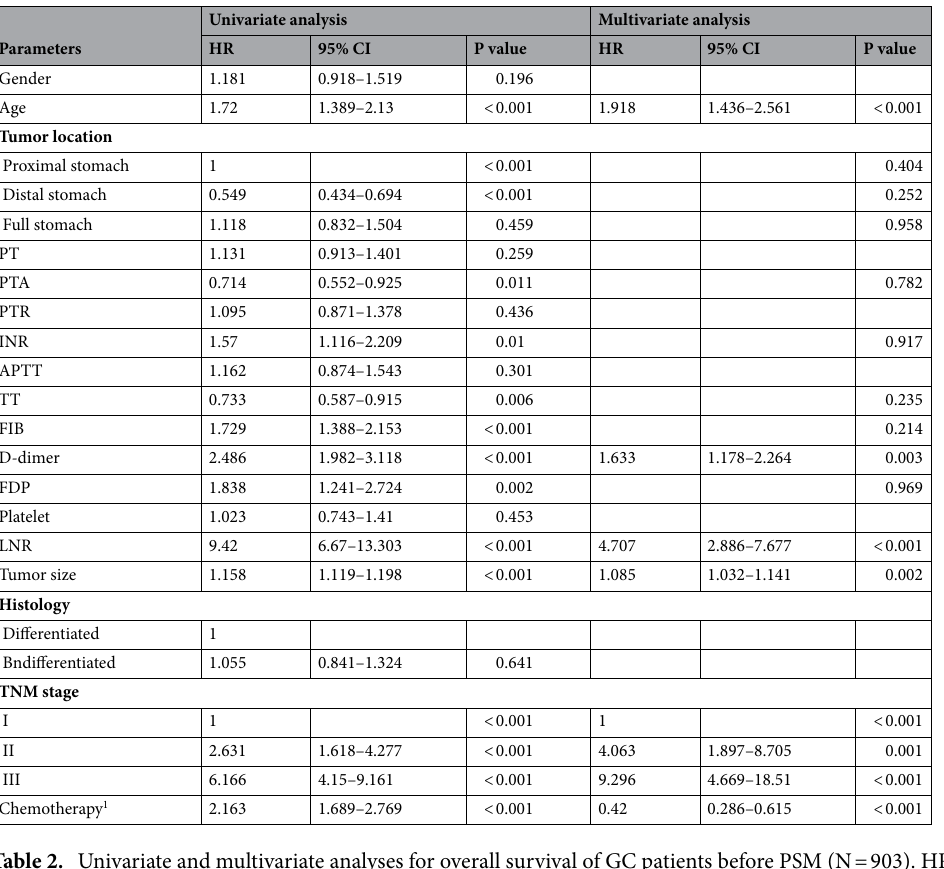
Table 2. Univariate and multivariate analyses for overall survival of GC patients before PSM (N = 903). HR, hazard ratio; CI, confidence interval; PT, prothrombin time; PTA, prothrombin activity; PTR, prothrombin ratio; APTT, activated partial prothrombin time; INR, international normalized ratio; TT, thrombin time; FIB, fibrinogen; FDP, fibrin degradation products; TNM, Tumor-node-metastasis; LNR, Lymph node ratio. Coagulation parameters were divided into two groups according to the cutoff values in Supplementary Table 2. The references of parameters were female, age < 65 years, PT < 13.2, PTA < 102.6, PTR < 1, INR < 0.96, APTT < 38.9, TT < 16.5, FIB < 3.8, D-dimer < 1, FDP < 2.1 and Platelet < 300. LNR and tumor size is analyzed as a continuous variable in univariate and multivariate analyses. 1 This refers to adjuvant chemotherapy, the reference was no chemotherapy; adjuvant chemotherapy appeared to be a risk factor in univariate analysis because cox regression analysis included patients with TNM stage I who did not receive adjuvant